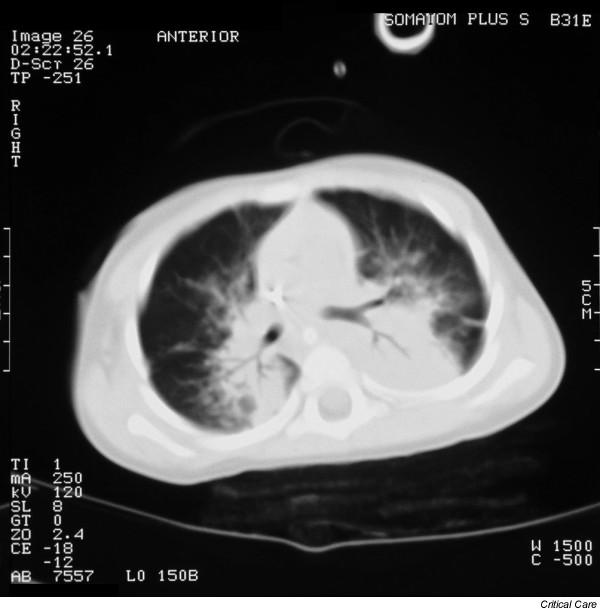
The girl: computed tomography of the thorax, done shortly after admission to hospital, showing infiltrations in the basal dorsal thorax following aspiration.